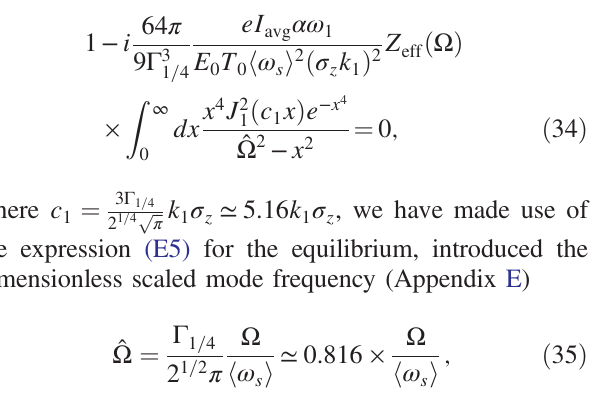
FIG. 4. Keil-Schnell diagrams representing the complex-number frequency solutions of the dispersion-relation equation Eq. (38) for mode l ¼ 0 (left) and l ¼ 1 (right) for optimum HHCs (top). Equation (38) is derived from a quartic potential model but we also try to apply it to the two ALS HHC case (bottom pictures) and find estimates that are within 10% of the more accurate results of Sec. III. A mode with impedance parameter ζ defined in (37) is stable (Landau damping) if ζ falls within the region delimited by the dashed eff eff curve containing the origin: this is the case for the l ¼ 1 mode in the presence of optimum HHCs (top-right picture). The values ˆ Ω appearing in the pictures are for the scaled frequency defined in Eq. (35); for the corresponding values in physical units see Table